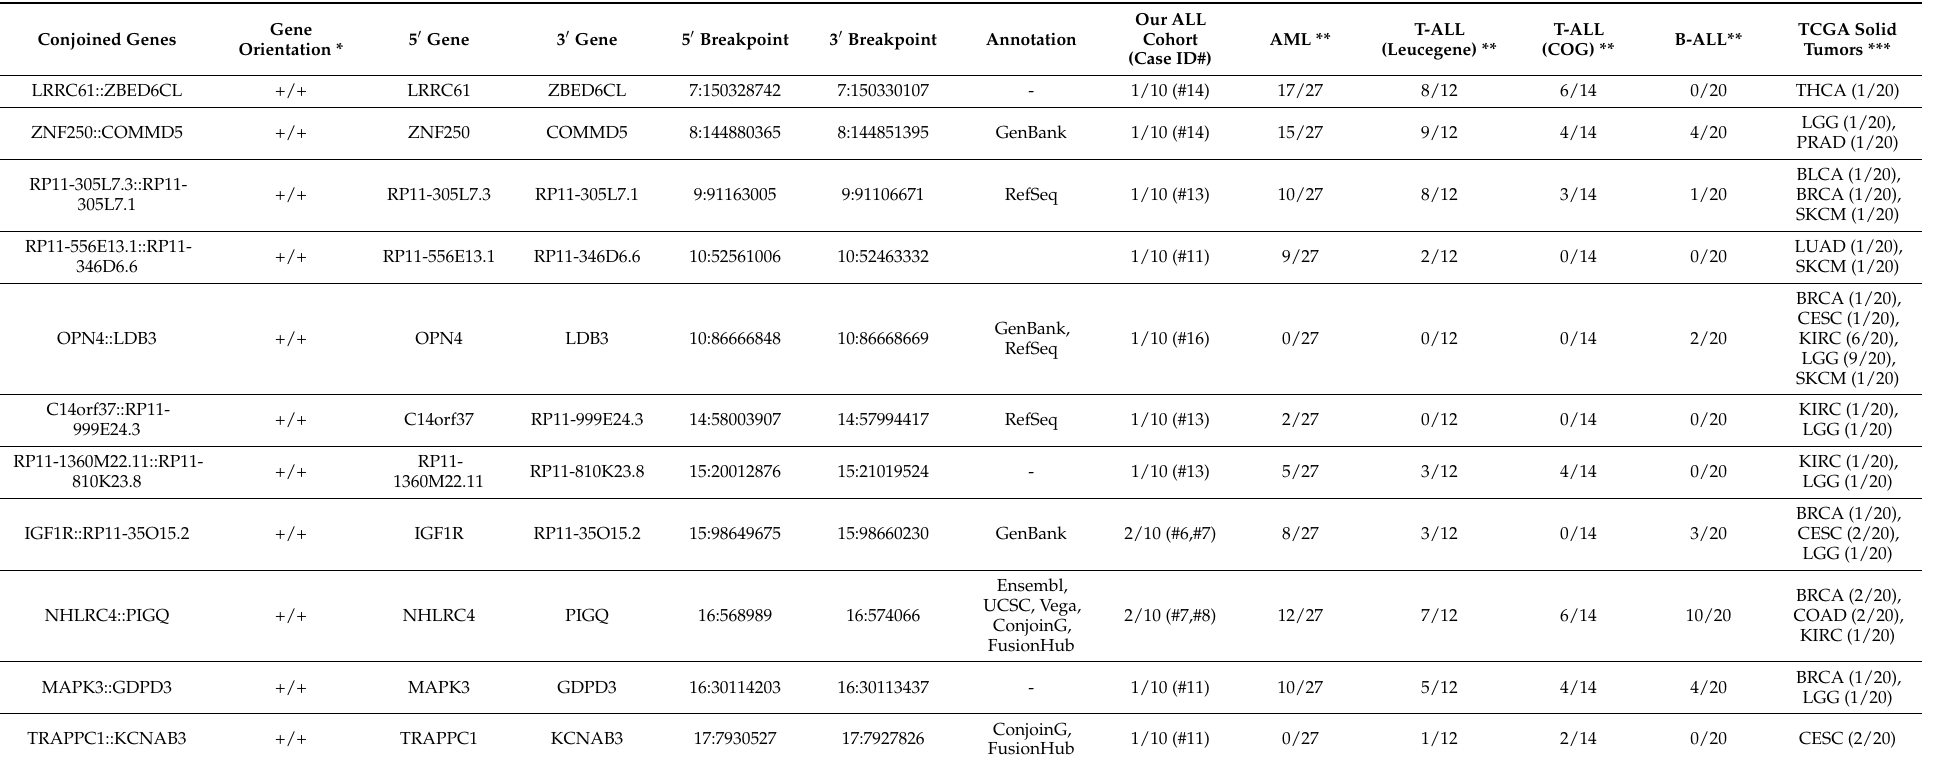
Table 2. CGs shared by leukemia and solid